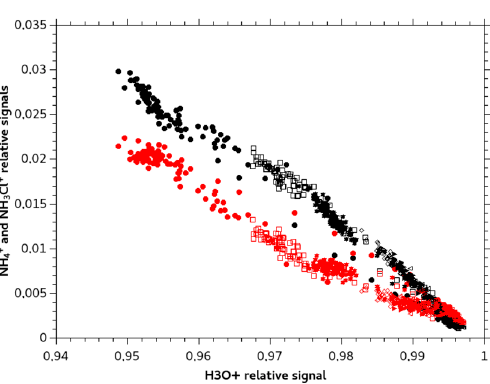
Figure 5. NH 4+ ( m / z 18) signal in red and NH 3 Cl + ( m / z 52) signal in black compared to H 3 O + signal (precursor) during transient and stable MIMS response for different concentrations.